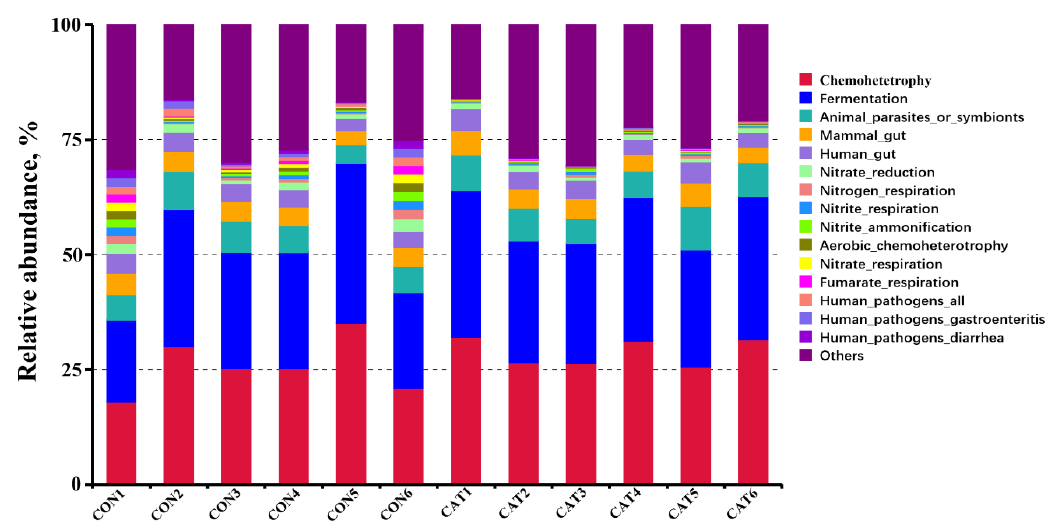
Figure 6. Relative abundance of the predicted function of colonic microbiota in two experimental treatments. CON 1, 2, 3, 4, 5, and 6 are colonic digesta samples from piglets fed with a basal diet; CAT 1, 2, 3, 4, 5, and 6 are colonic digesta samples from piglets fed with a basal diet supplemented with 2.0 g / kg exogenous catalase